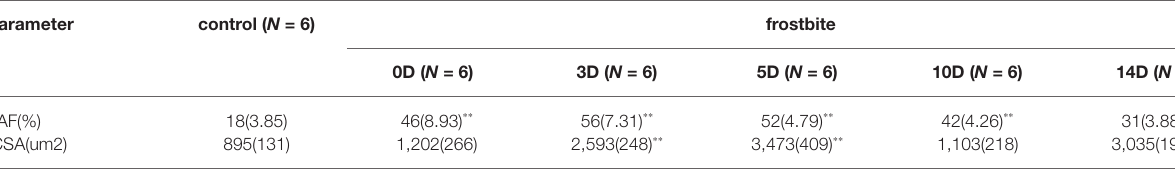
TABLE 2 | EAF and fCSA in frostbite and control.